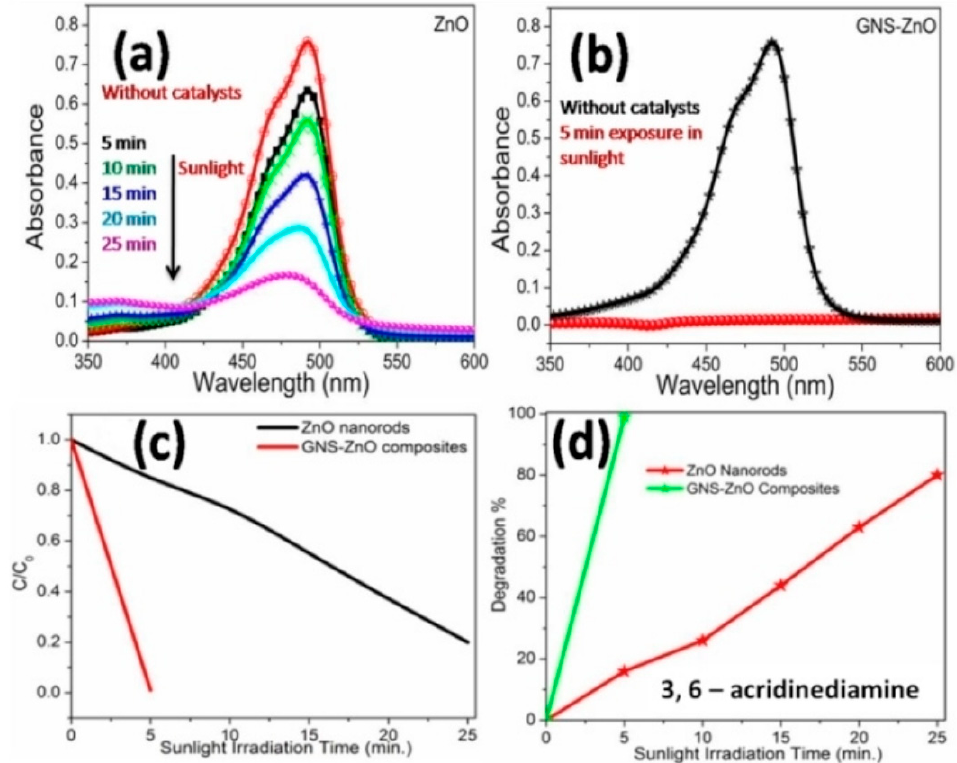
Figure 27. Photocatalytic degradation of 3, 6–acridinediamine compound under sunlight irradiation using ( a ) 1D ZnO NRs, ( b ) 1D ZnO–few layer graphene-based hybrid nanostructures, ( c ) initial and residual concentration plot vs. time, and ( d ) degradation % of pollutant vs. time. Reprinted with permission from [157].